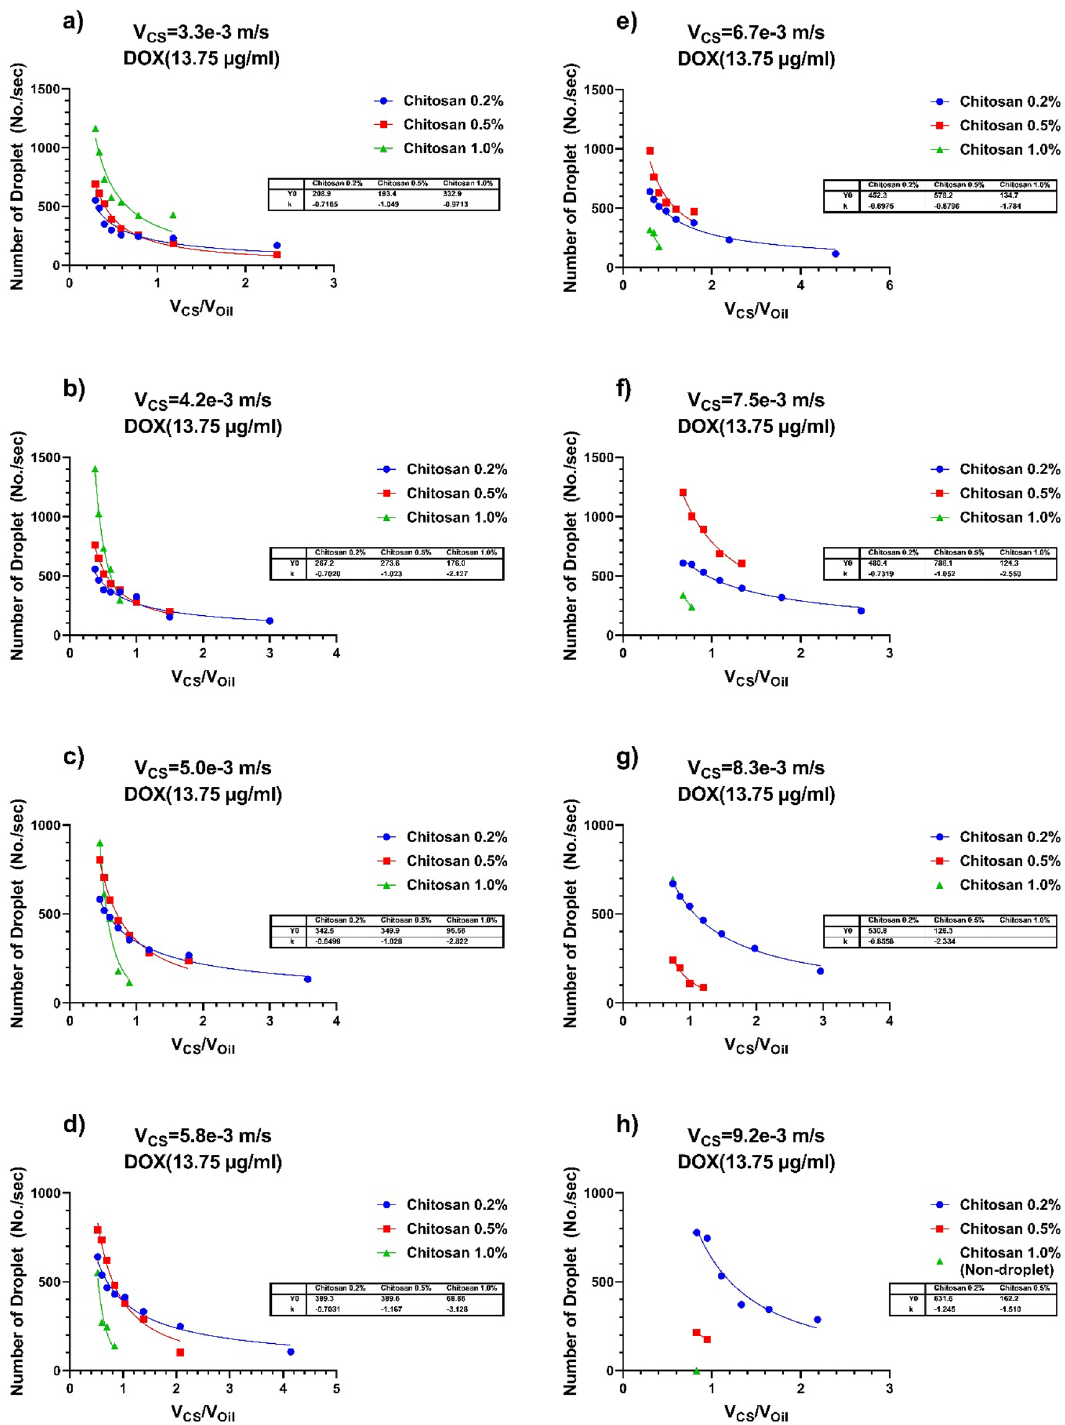
Figure 7. The consequence of velocity and concentration variations of CS-DOX and vegetable oil upon the number of droplet generation per unit time. The flow rate of vegetable oil and CS + DOX were selected at the limited area of 1.4 to 11.1 and 3.3 to 9.2 mm/s, respectively. The concentrations of CS are 0.2%, 0.5% and 1.0% (w/v), and also the concentration of DOX is 1.375% (w/v). For each subfigure, the CS + DOX velocity is fixed and the flow rate of the vegetable oli varies from 1.4 to 11.1 mm/s. The CS + DOX flow rate is ( a ) 3.3 mm/s, ( b ) 4.2 mm/s, ( c ) 5.0 mm/s, ( d ) 5.8 mm/s, ( e ) 6.7 mm/s, ( f ) 7.5 mm/s, ( g ) 8.3 mm/s and ( h ) 9.2 mm/s. Continuous lines are curves plotted on experimental data using the power equation (Y = Y 0 * X k ). The values of Y 0 and K of each of these curves are shown in the table in each